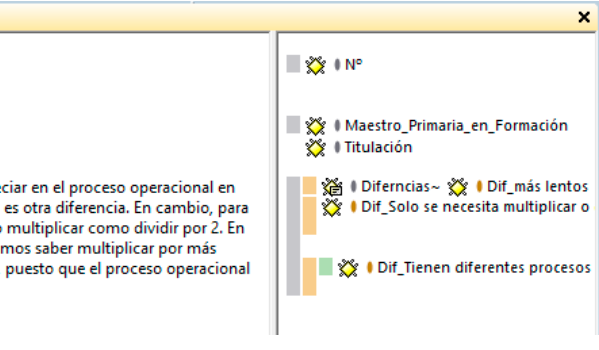
Figure 3. Codification of information in ATLAS.ti.